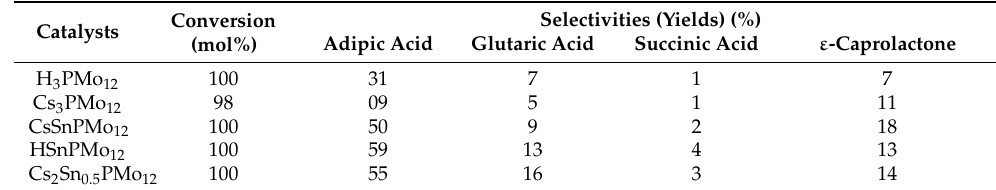
Table 6. Catalytic performances of POMs for cyclohexanone